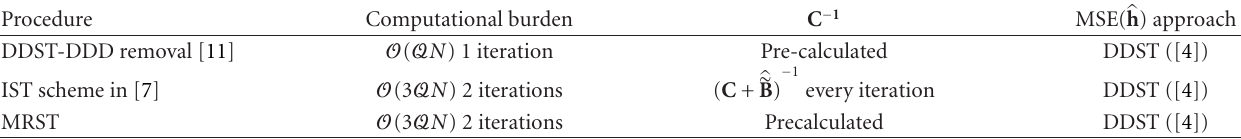
Table 1: Synoptic Table of the Computational burden, C − 1 Computation and the Channel Estimate